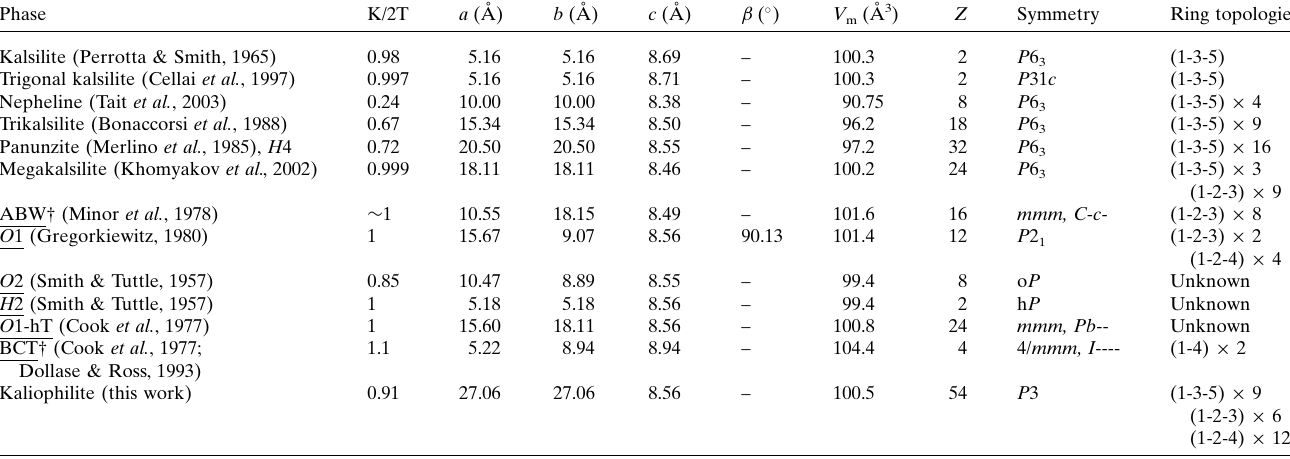
Table 1 The 12 known phases with compositions close to KAlSiO 4 and based on tridymite topology and its variants, along with nepheline (Na,K)[AlSiO 4 ]. K/2T = [K/(Al + Na)], cell parameters and ring topologies are reported for each phase. Formula volume V m and cell content Z refer to (K,Na)AlSiO 4 . In the ‘Symmetry’ column, the space group of the structure is indicated, whenever it is known; otherwise, any available symmetry information (lattice, Laue class, diffraction symbol) is given. Synthetic phases are